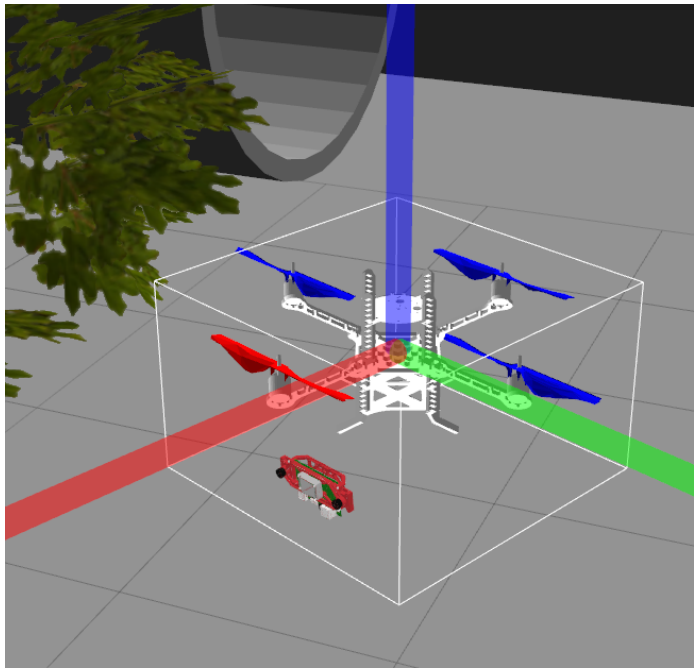
Figure 4. The simulated Ascending Technology Pelican quad-copter carrying a depth sensor in Gazebo sim. controlled by our proposed algorithm in our challenging environment explained in Section 4 of this